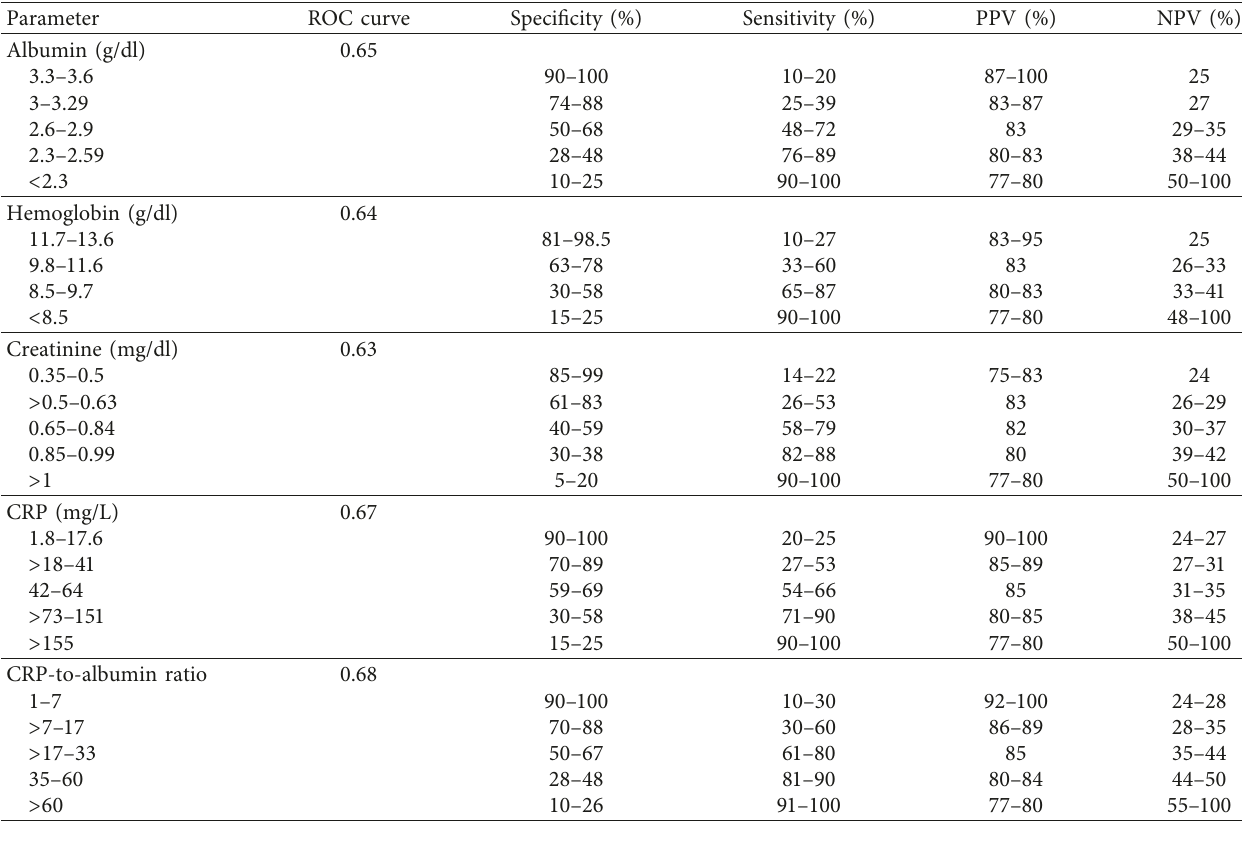
ROC curve for selected model Area under the curve = 0.7274